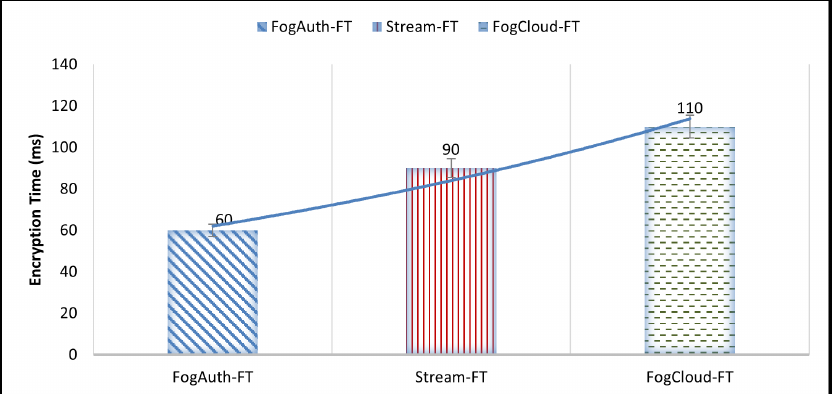
Figure 3. Encryption time with a key size of 128 bit and a block size of 192 bit.